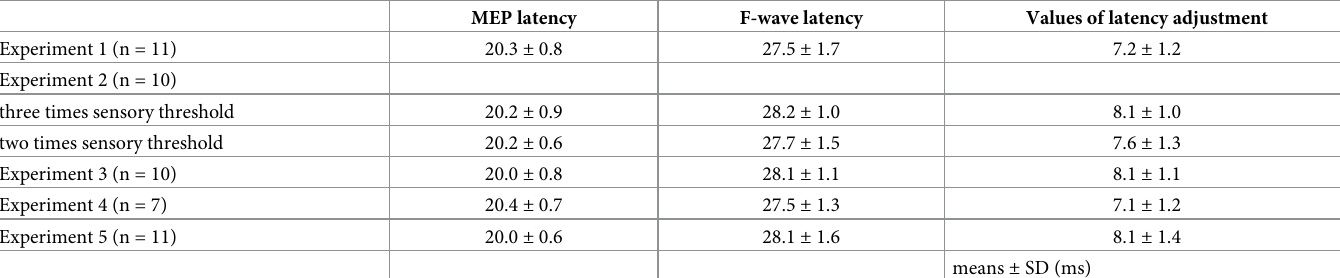
Table 1. MEP and F-wave latencies, values of latency